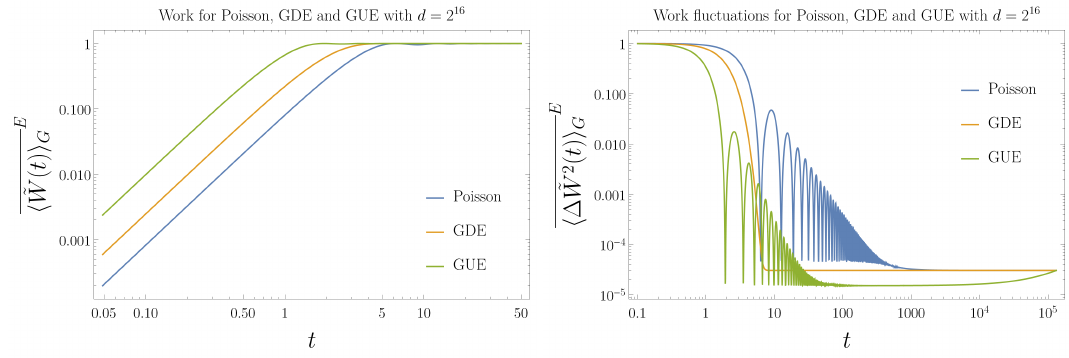
Figure 10: Left: Log-Log Plot of the normalized work in Eq. (73) for Poisson, GDE and GUE and d = 2 16 . The normalized work starting from 0 at t = 0 and reaches the value 1 in a time O ( 1 ) for the three ensembles. Right: Log-Log Plot of the quantity of Eq. (76) for Poisson, GDE, GUE ensembles, where d = 2 16 and h = 1. We observe that the timescales are dictated by the timescales of ˜ c , cfr. Table 2( Left 2